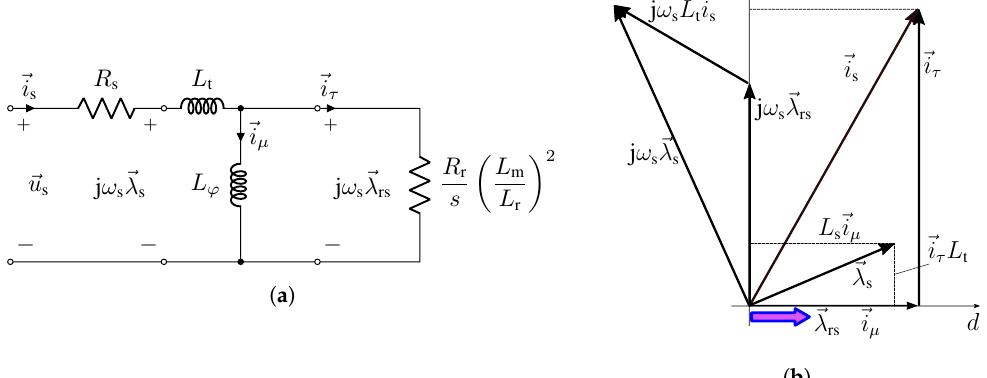
Figure 2. IM model in the dq rotor flux linkage oriented reference frame. ( a ) Inverse- Γ model of IM; ( b ) space vector diagram in the dq synchronous reference